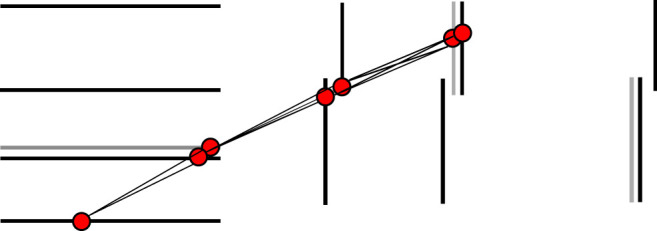
A typical Fishbone
n-tuplets. The shadowed areas indicate partially overlapping modules in the same layer.